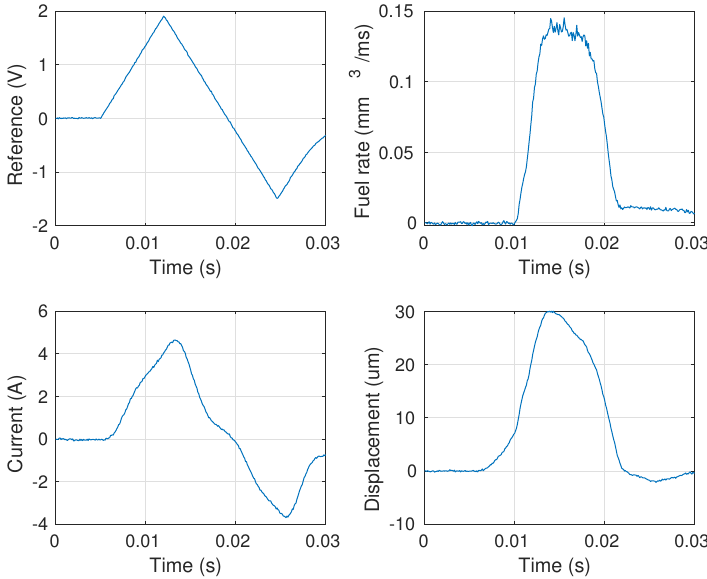
Figure 7. Measured signals with triangular reference with t inj = 12 ms and P inj = 40 MPa. A second test is to verify the effect of the reference amplitude on the various signals. Figure 8 shows the comparison among square-shaped signals at the injection pressure of P inj = 50 MPa and shorter pulse width, t inj = 5 ms. The currents and the displacements clearly follow the reference signals, while the injection rates have perfectly overlapping rise-times and plateau zones (corresponding to the maximum flux at full-opened nozzle) with scaled longer spans with respect to the stimulus, indicative of a persistence at higher voltages. This may be justified by the previous reasons. Finally, Figure 9 shows the comparison of triangular references with different amplitudes, and, in this case, different injection rates are achieved. A similar behavior is obtained with a longer pulse width, t inj = 10 ms, as shown in Figure 10.